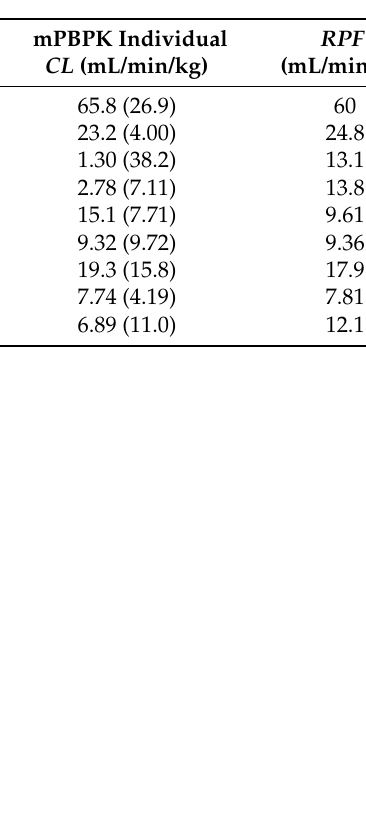
a The jointly-fitted CL values are listed in Table 3. b AIC = 248.19. c Estimated as a secondary parameter by f d 2 = f d , total − f d 1 . Table 3. Comparison of systemic clearance values of metformin for 9 species based on the indicated methods of calcula- tion/estimation (CV% obtained by fitting).